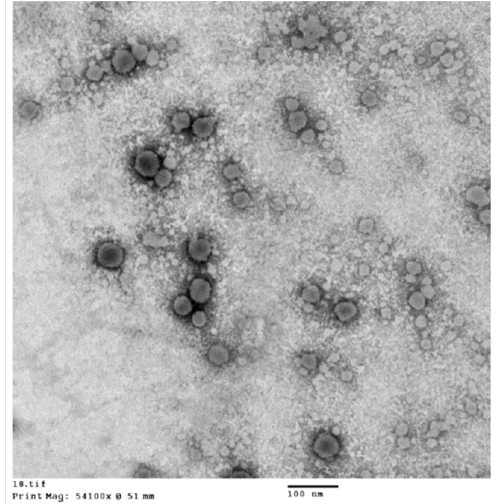
Figure 6. Visualization of ASP lipid nanocapsules (F22-AS) showing dense shells and light